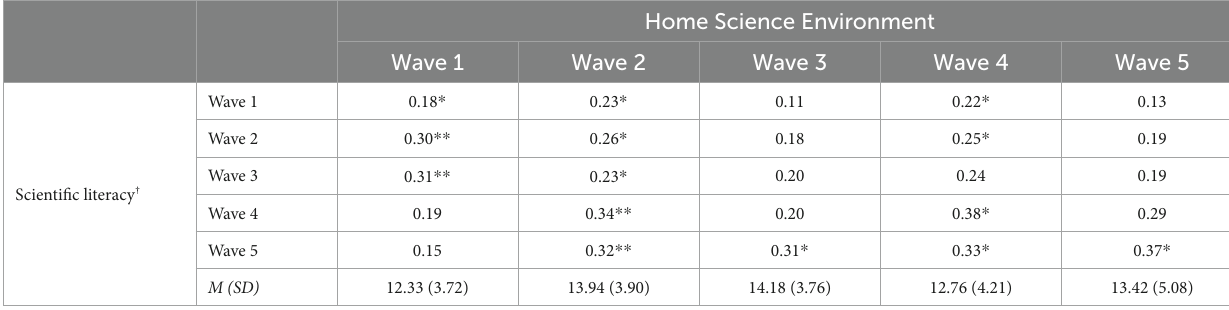
TABLE 7 Bivariate correlations for home science environment and scientific